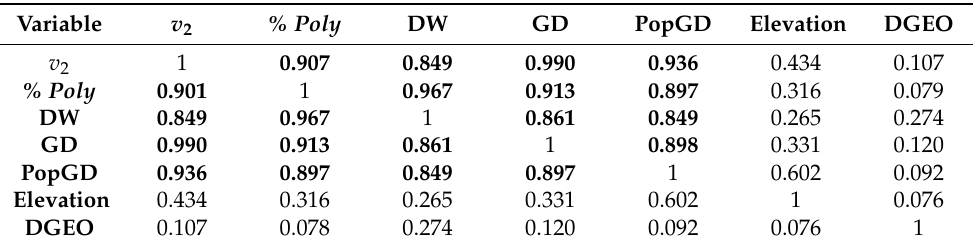
Table 5. Correlations between genetic and geographic variants of Pinus engelmannii and the different peripheral and central populations of this species.